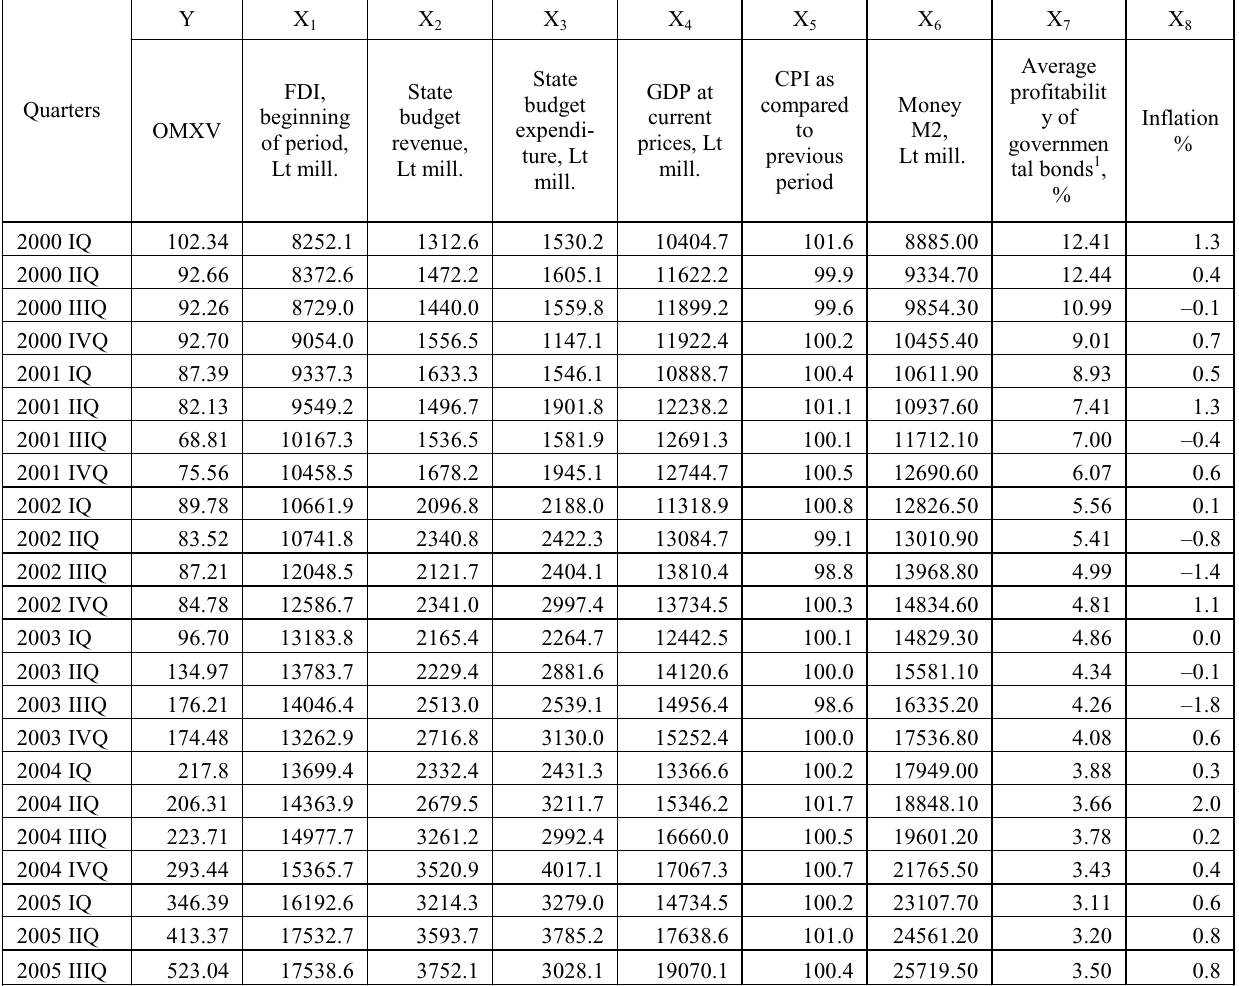
Table 1. Data for the empirical research of stock prices dependence on macroeconomic